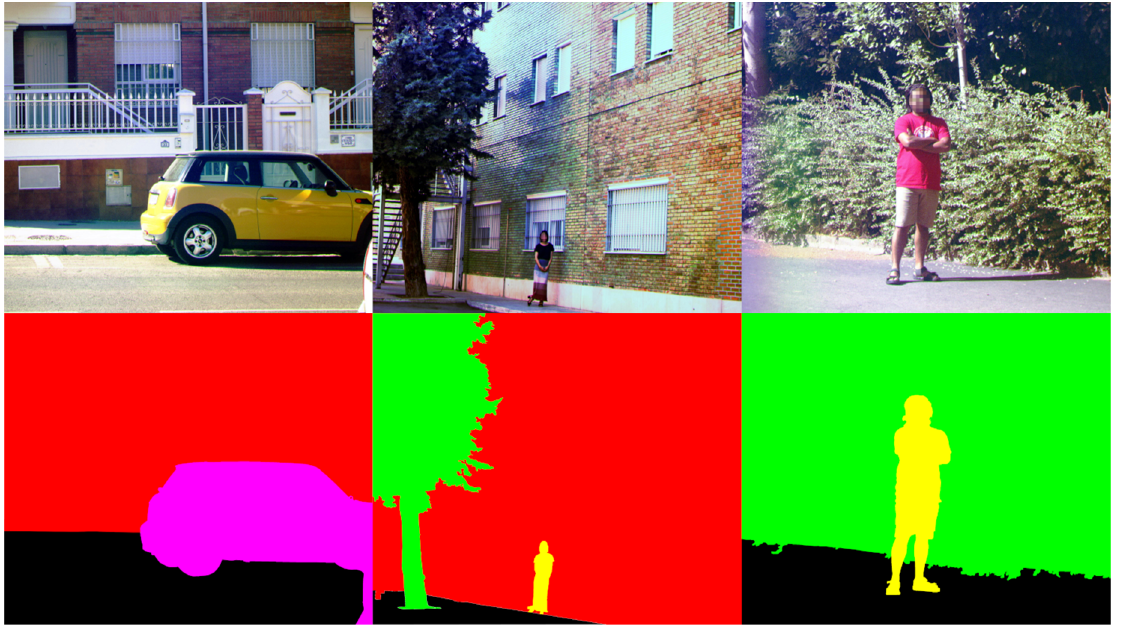
Figure 5. Top row: 3 example RGB images used in the experiment. Bottom row: manual segmentation of the top-row images. In the bottom left, 2 categories are present, which include building (red) and vehicle (pink). In the bottom center, 3 categories are present: vegetation (green), building (red), and people (yellow). In the bottom right, 2 categories are present: vegetation (green) and people (yellow). In all cases, ground is represented in black, and no category is assigned to